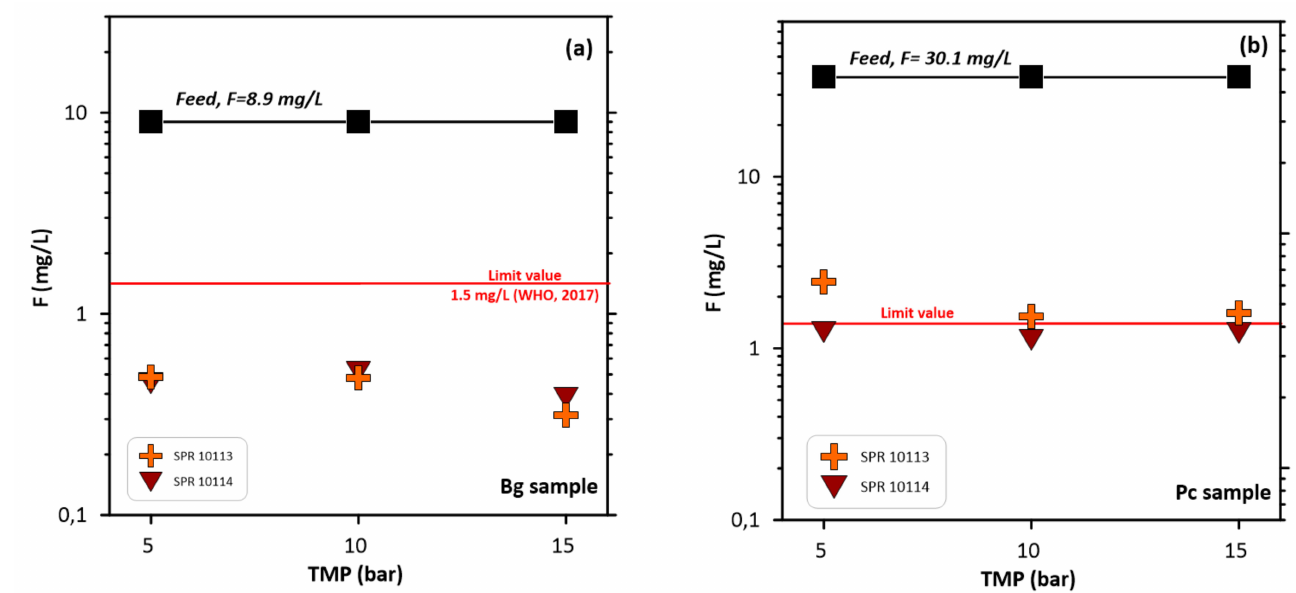
Figure 6. The effect of TMP on the fluoride concentration in the permeates obtained by using the membranes SPR 10113 and SPR 10114 for ( a ) the Bg and ( b ) the Pc samples,